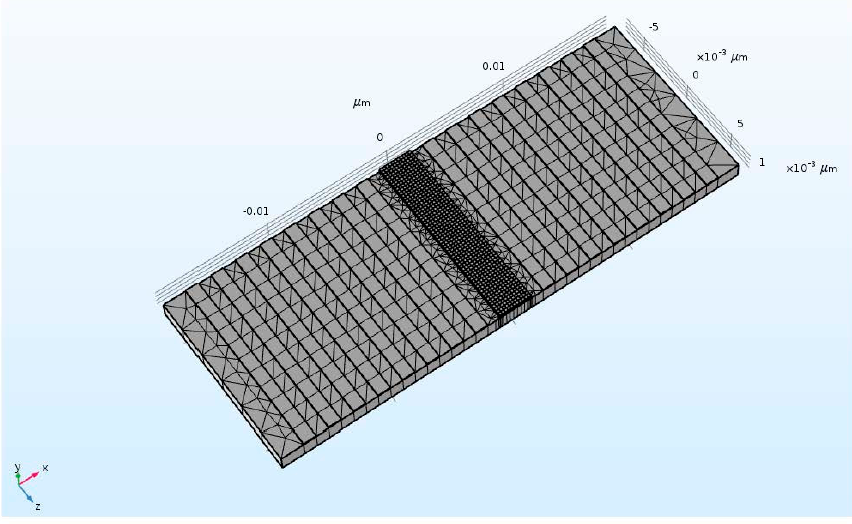
Figure 1. The mesh